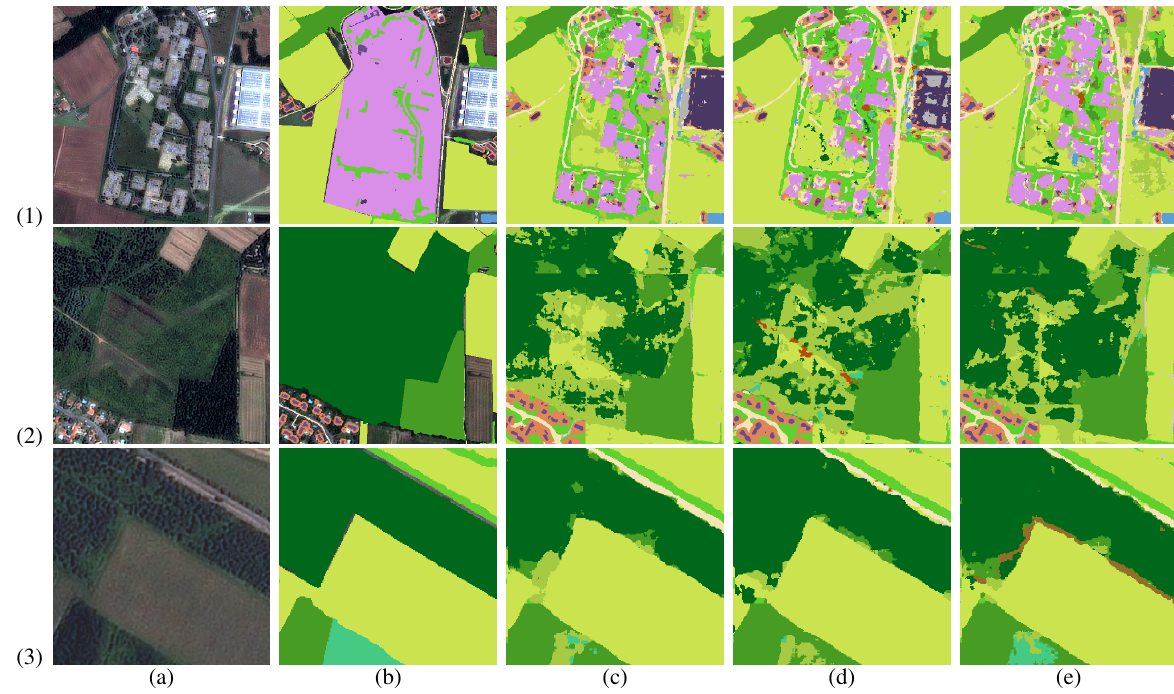
Figure 4. Rows : (1) Cemetery, (2) Forest area, (3) Countryside area. Columns : (a) SPOT image, (b) Ground truth, (c)